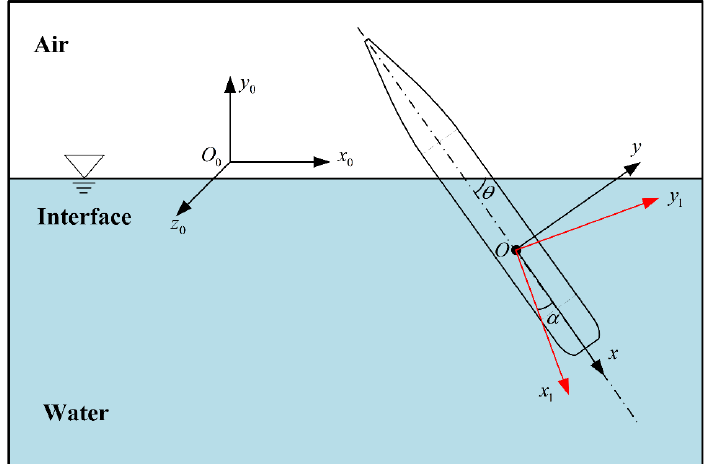
Figure 3. Coordinate system.